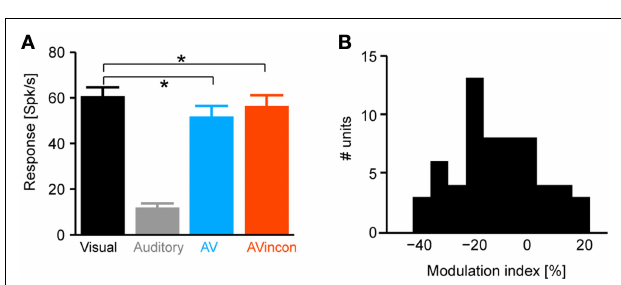
FIGURE 2 | Modulation of response amplitude. (A) Peak response amplitudes computed using a 80-ms window centered on the peak of the unimodal visual response. Bars indicate the mean and standard error across units. *indicate signifi cant differences, sign-test p < 0.001. The scatter plot displays the same data on a unit by unit basis, displaying the amplitude in each bimodal condition versus the amplitude in the unimodal visual condition. (B) Distribution of the multisensory modulation index across units. The modulation index was defi ned as the percent difference between the bimodal and unimodal responses divided by their sum (index = 100 × (AV − V)/(AV +